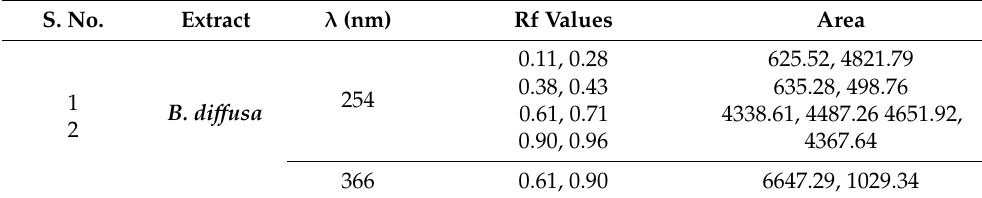
Table 1. Rf values and area of each spot of HPTLC fingerprinting of methanolic extract. S. No.